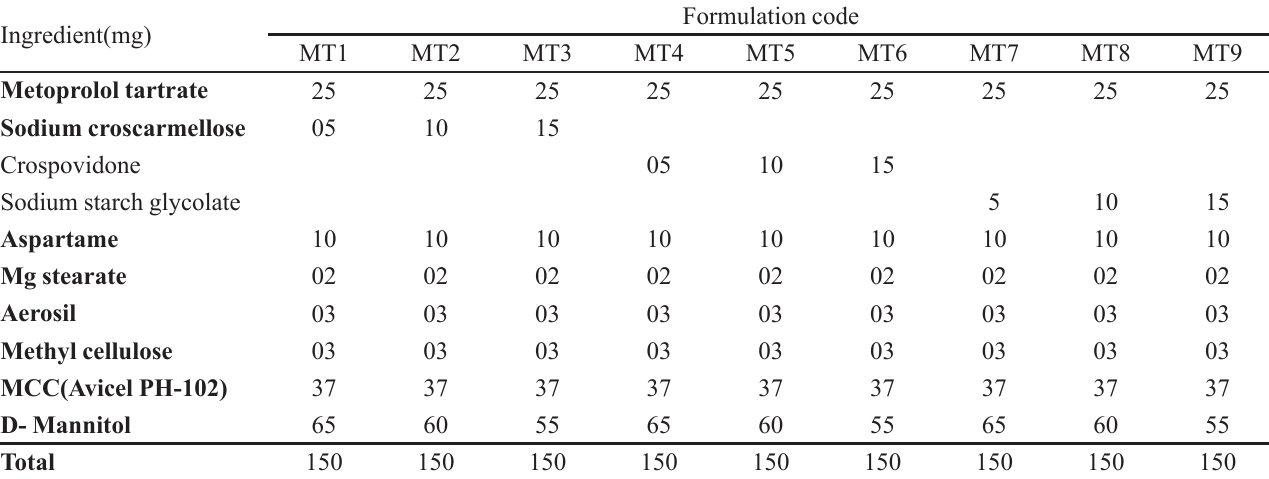
TABLE I - Formulation of metoprolol tartrate fast dissolving tablets prepared by direct compression method Ingredient(mg)